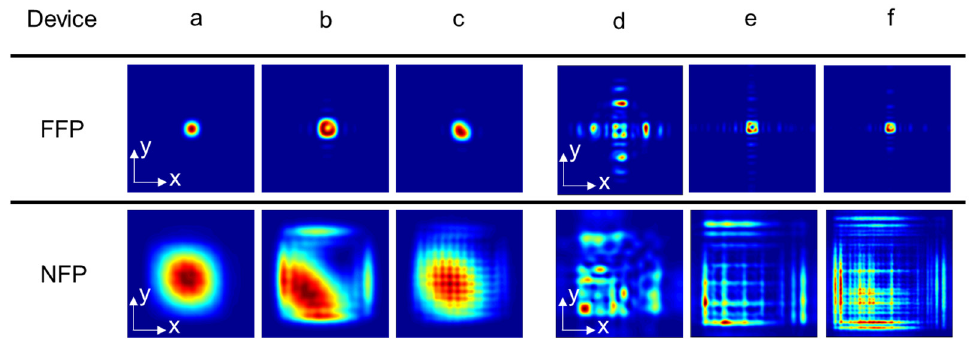
Figure 4. The FFP and NFP of devices with right isosceles triangular air holes. The former three groups are PhC slab clad by air, with the same period numbers of 31, but with various air filling factors and hole depths of ( a ) 20%, 160 nm, ( b ) 13%, 160 nm, ( c ) 13%, 320 nm, respectively. The latter three groups are PCSELs clad by dielectric layers, with the same air filling factor of 13% and hole depth of 160 nm, but various period numbers of ( d ) 31, ( e ) 61, ( f ) 101,